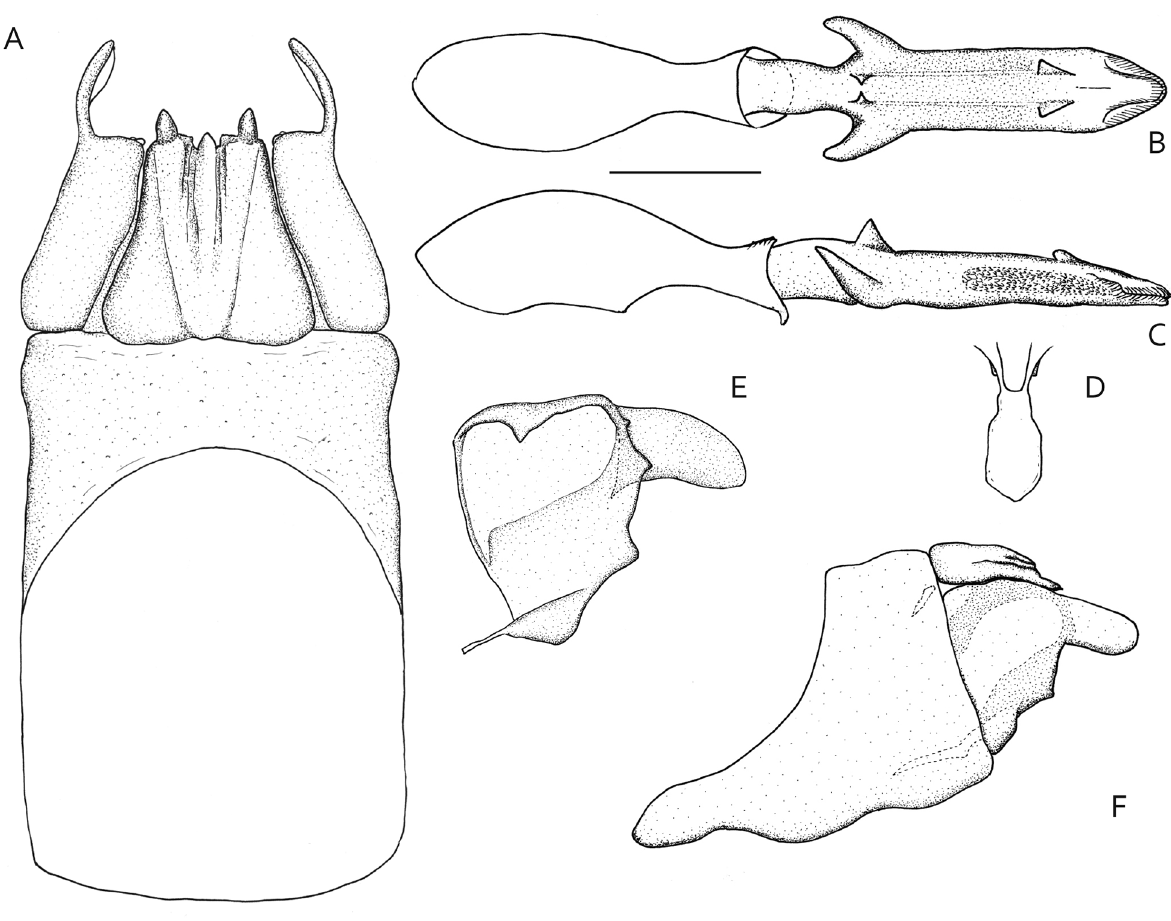
Figure 10. Male genitalia of Issikiomartyria leptobelos sp. n. [holotype]. A: genitalia capsule, dorsal view; B: phallus, dorsal